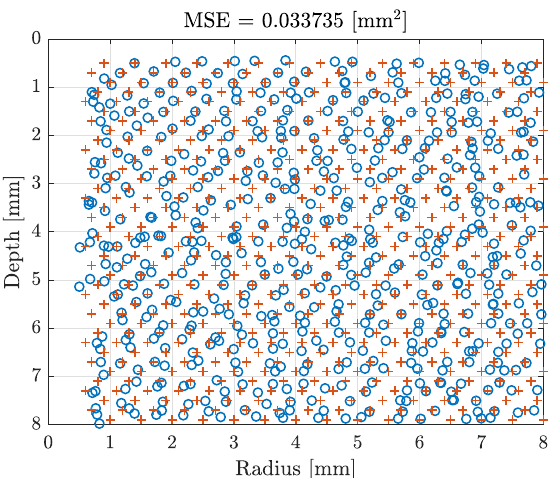
Figure 7. Estimated radii and depths (circles) compared with real parameters (crosses) for the test data using the data fusion EC and US.